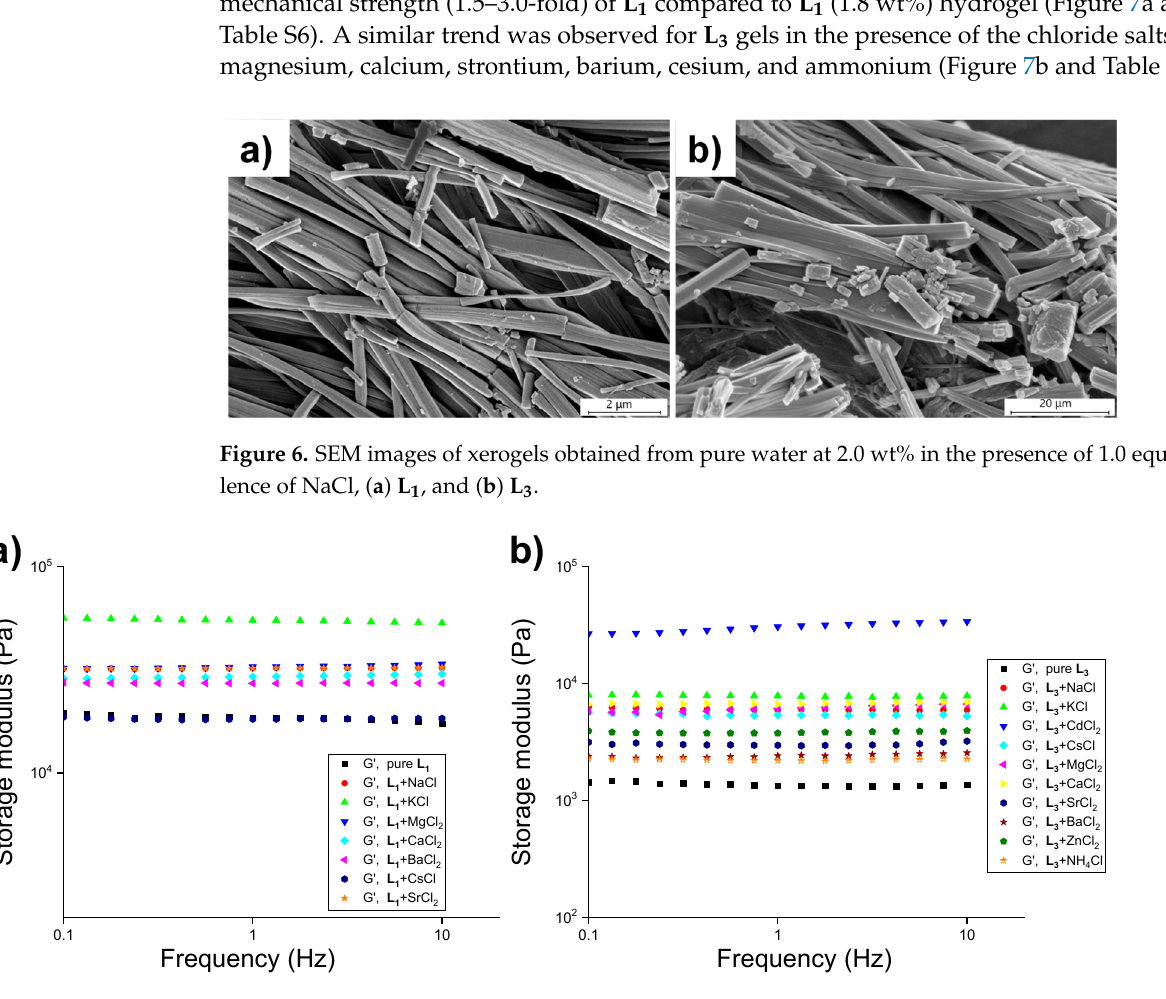
Figure 6. SEM images of xerogels obtained from pure water at 2.0 wt% in the presence of 1.0 equiv- alence of NaCl, ( a ) L 1 , and ( b ) L 3 .